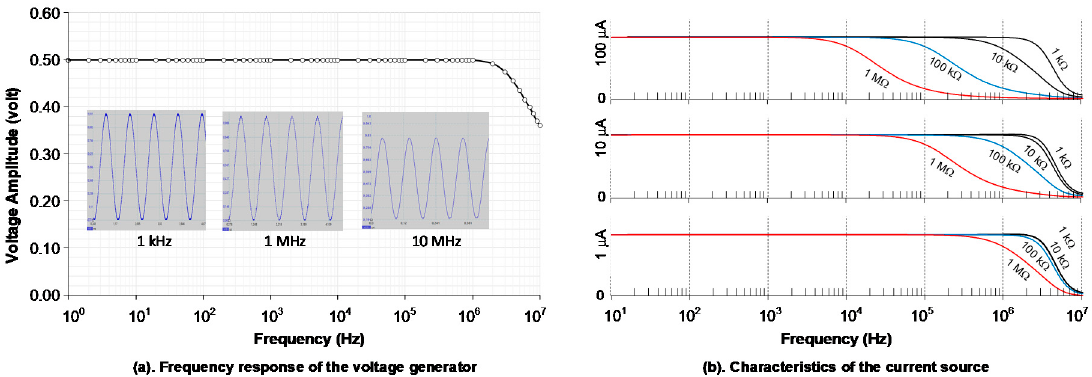
Figure 7. Current-source characteristics: ( a ) frequency response of voltage generator, and ( b ) frequency response of several current values of V/I converter output due to related load.